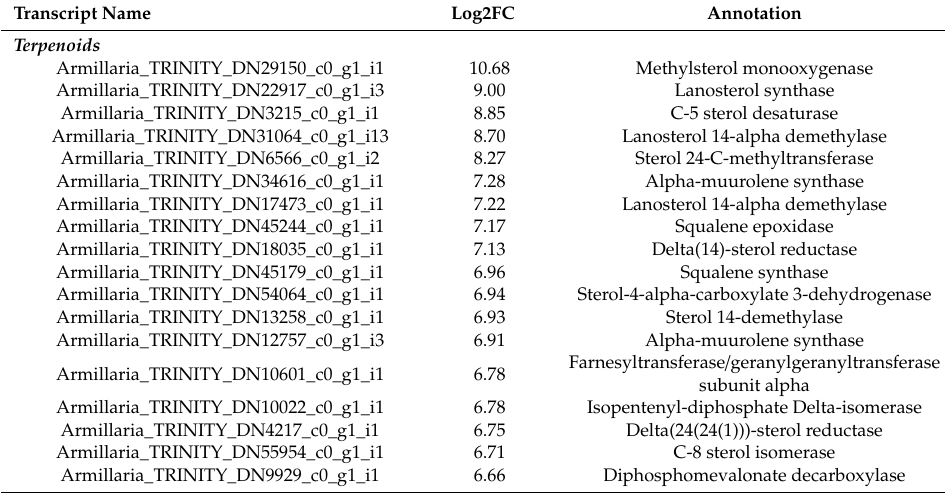
Table 6. Di ff erently expressed biotechnologically-relevant transcripts of A. sinapina cells in the presence of